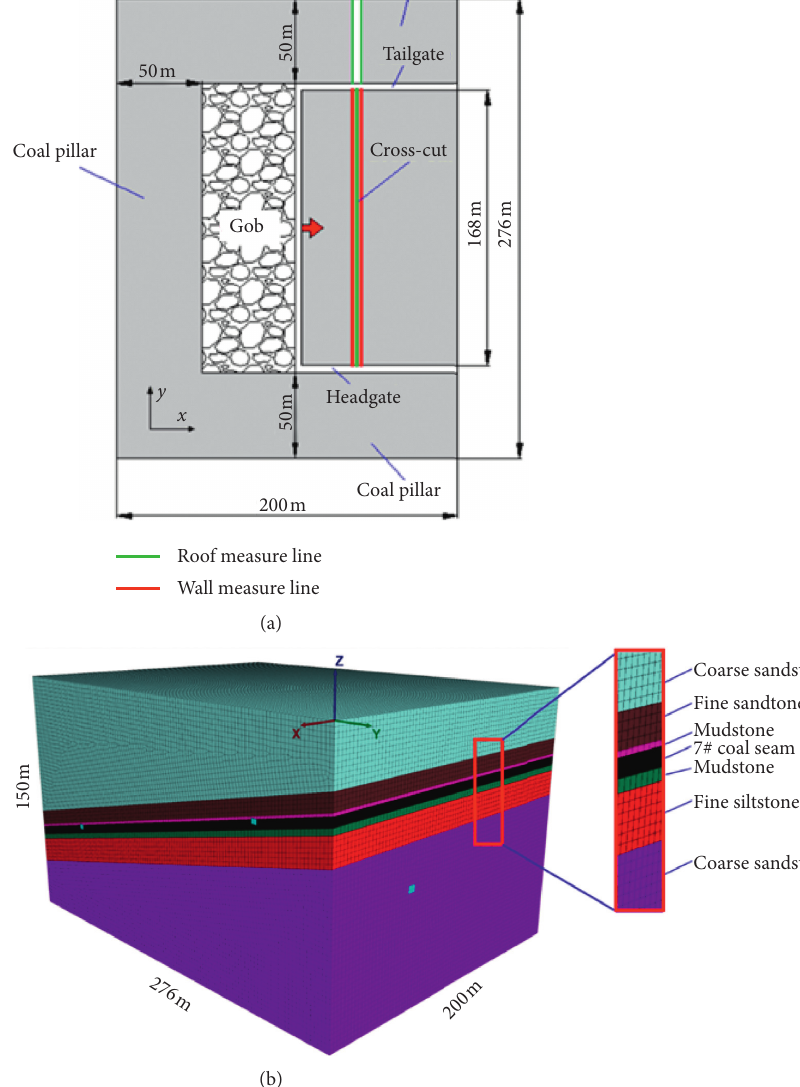
Figure 8: Numerical model configuration and measure line layout.